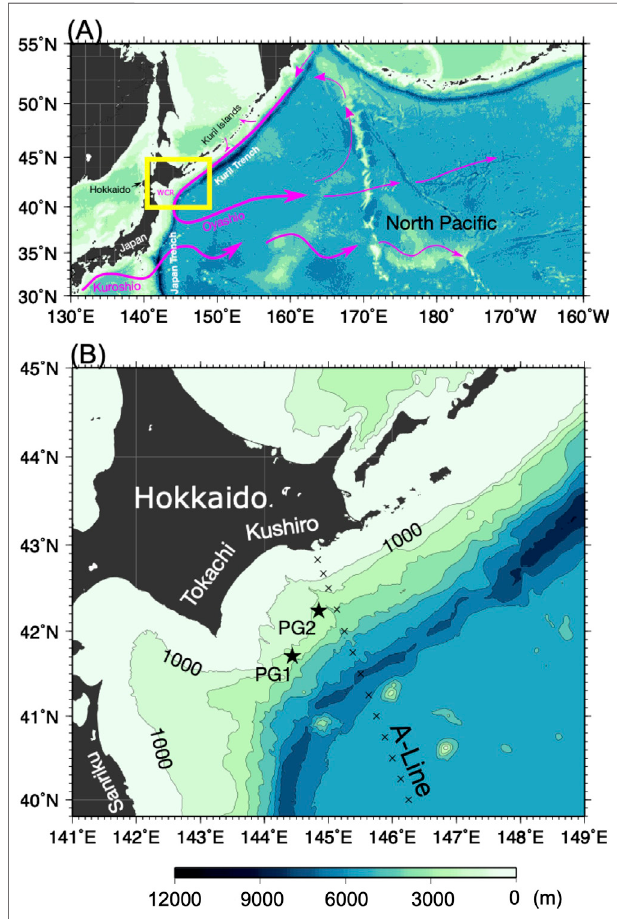
FIGURE 1 | (A) Map of the western North Paci fi c. Sea surface currents (Kuroshio and Oyashio) are schematically shown by purple arrows. (B) Map for the analysis area off Tokachi and Kushiro (off the southeastern coast of Hokkaido) marked by a yellow square in (A) with bottom topography. Contourintervalis1000m.Onthecontourof1000mdepth,acontourlabelis shown. The ocean bottom pressure gauges (PG1 and PG2) are marked by black stars and the CTD stations at A-line by black